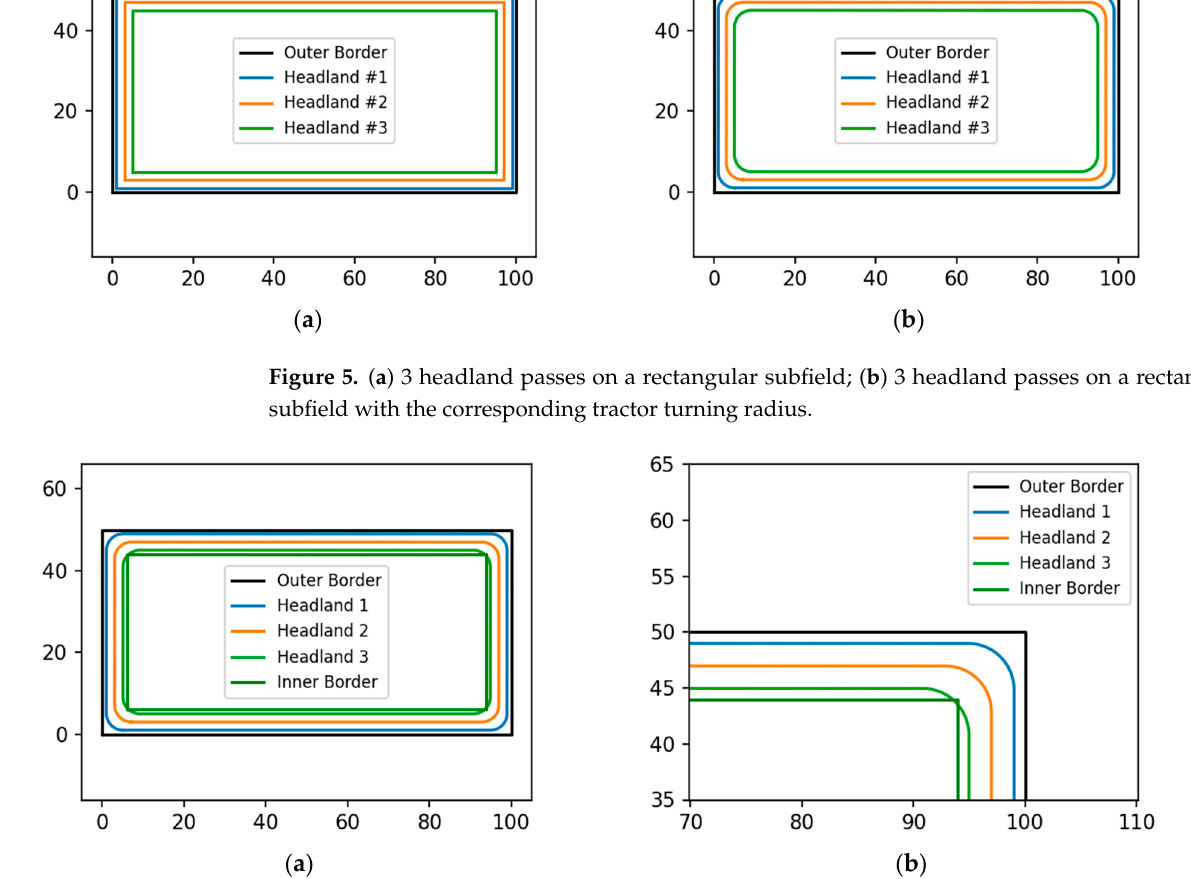
Figure 5. (a ) 3 headland passes on a rectangular subfield; (b) 3 headland passes on a rectangular subfield with the corresponding tractor turning radius.